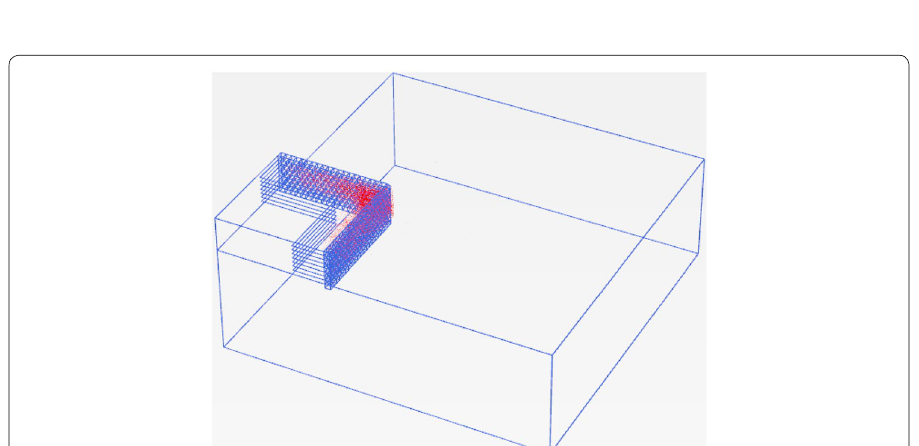
Fig. 26 Total displacement vectors of Case 1